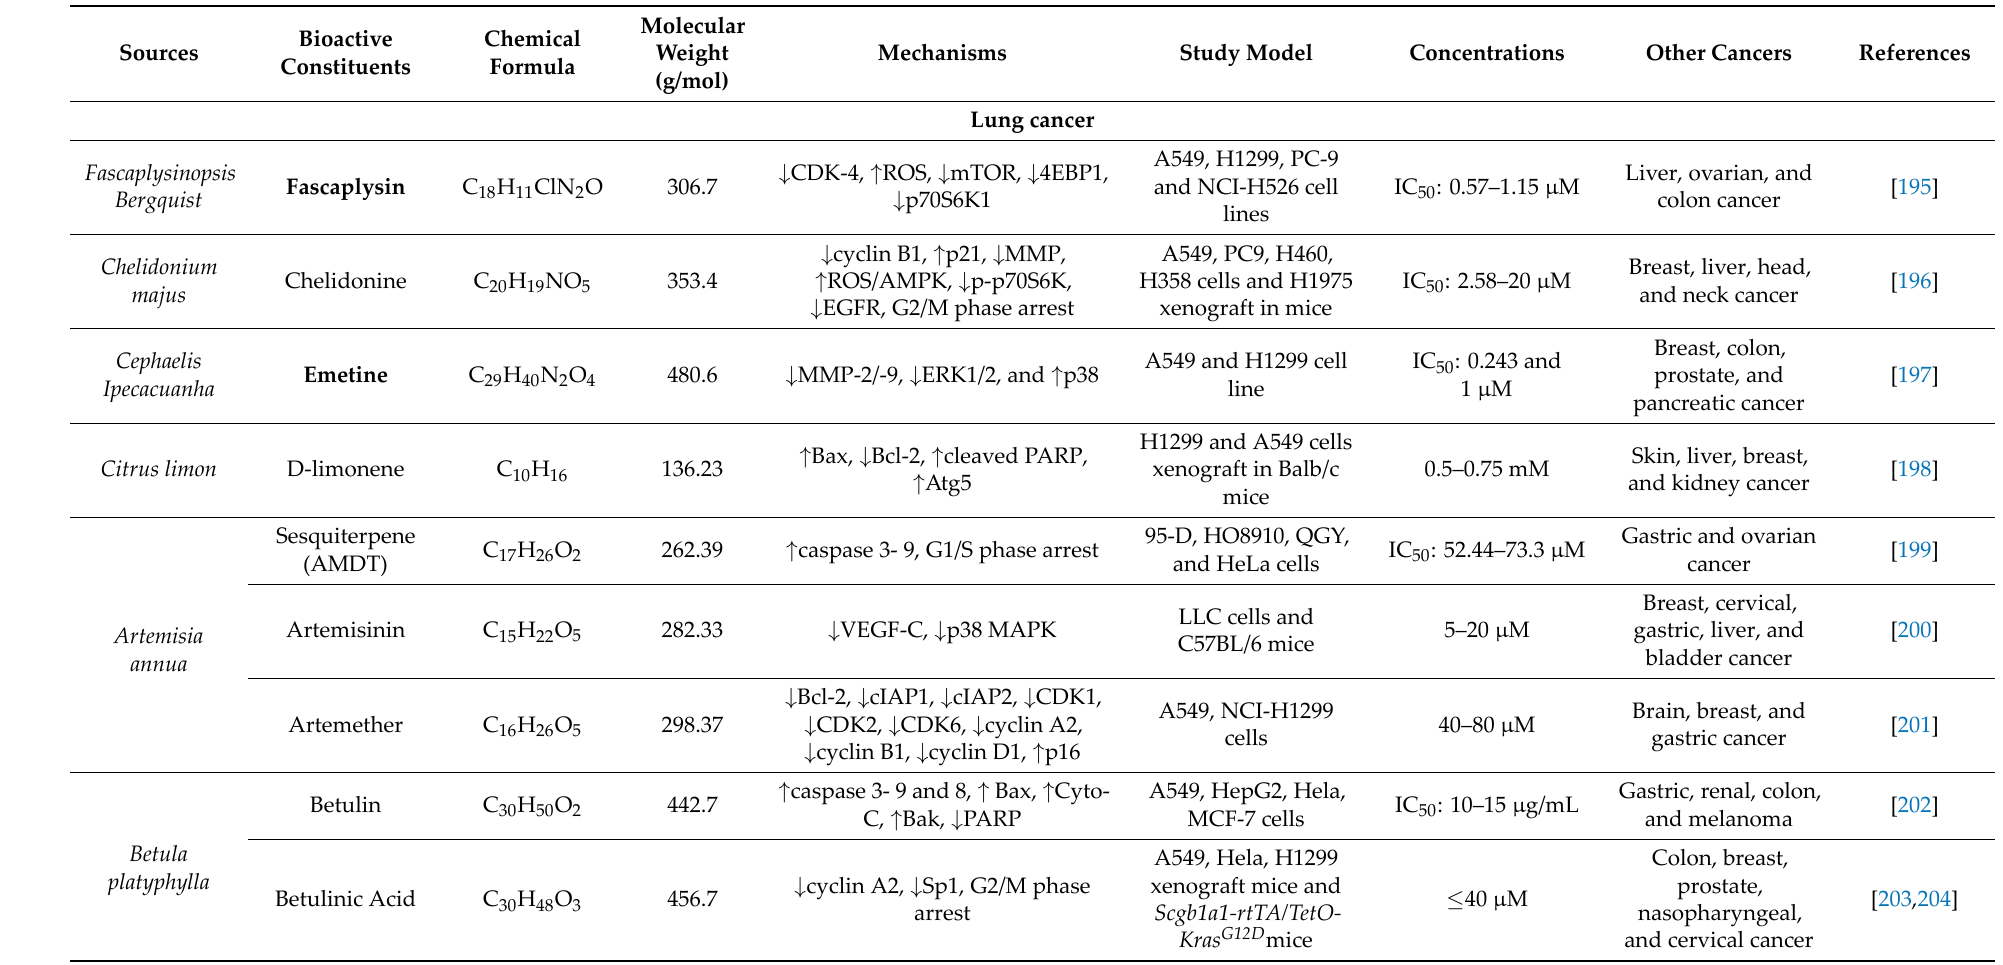
Table 1. Some of the important natural products in managing different types of